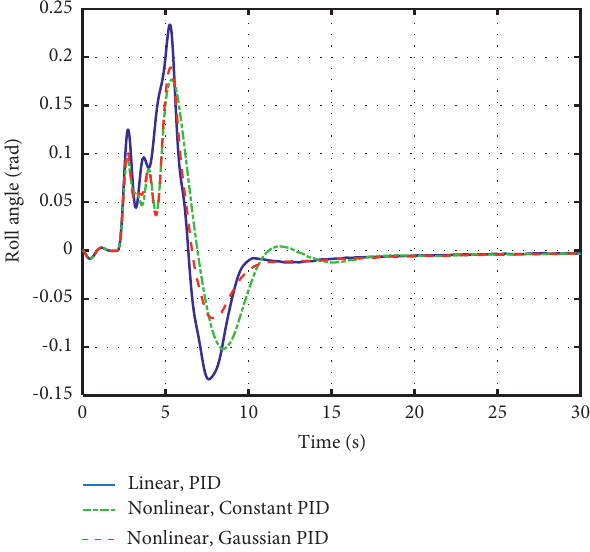
Figure 14: Comparison of the vehicle roll angle.